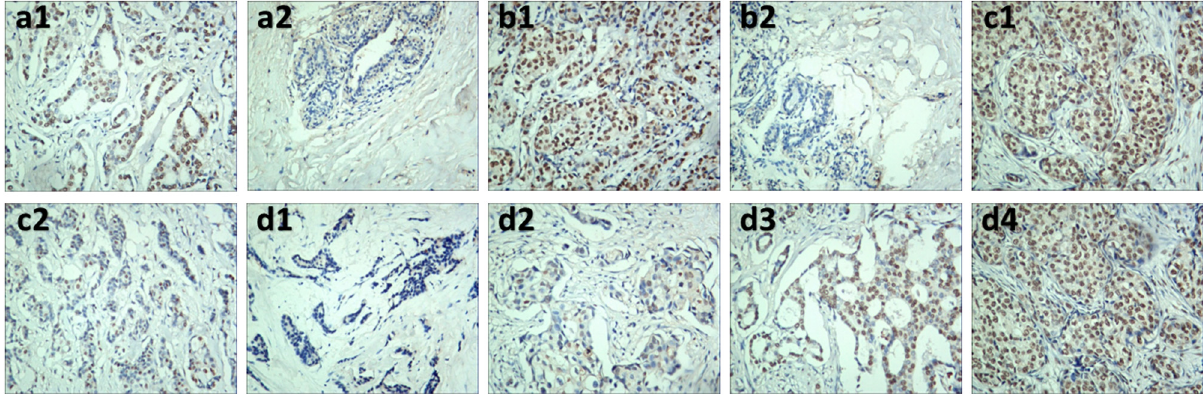
Figure 3: Representative IHC staining of TRIM28 in BC tissues and corresponding tissues adjacent to cancer ( IHC × 200 ) . a1 – b2: TRIM28 expression in two groups of BC and adjacent tissues, a1 and a2 were in the fi rst group, b1 and b2 were in the second group, a1 and b1 were cases of breast cancer tissues, a2 and b2 were cases of adjacent tissues. c1 and c2: c1 was a case of TRIM28 expression in triple - negative breast cancer, and c2 was a case of TRIM28 expression in non - triple - negative breast cancer. d1 – d4: TRIM28 expression in di ff erent TNM stages, d1 was at stage 0, d2 was at stage I, d3 was at stage II, d4 was at stage